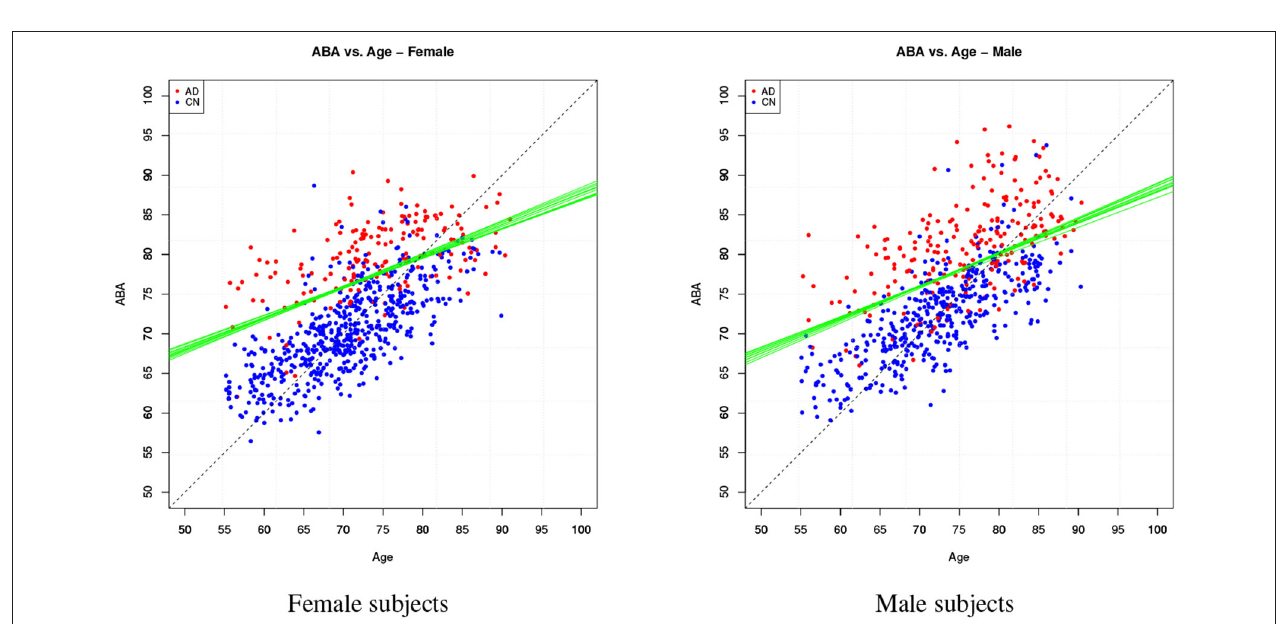
FIGURE 5 | Method M6: Apparent Brain Age vs. chronological age for the male gender group.